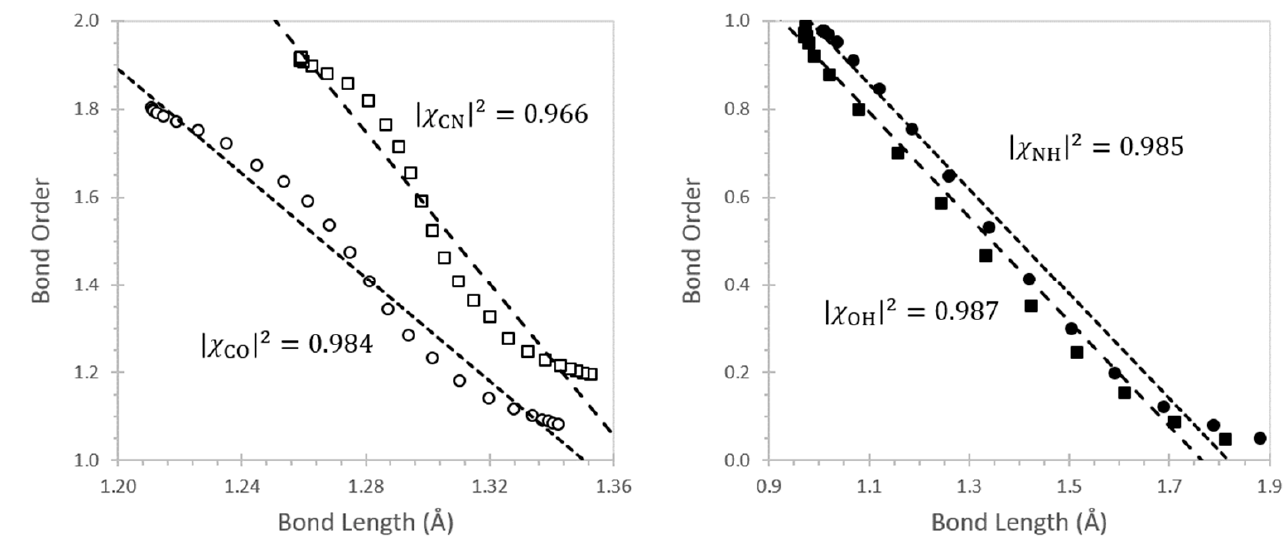
Figure 7. Bond order–bond length correlations for CO (circles), CN (squares), OH (filled circles), and NH (filled squares) bonds, showing the least-squares regression line and corresponding Pearson | χ | 2 correlation coefficient for each bond type. Variations in the NRT weights for the four resonance structures across the IRC, as well as concomitant changes in natural bond orders, are entirely consistent with the elec ‐ tron ‐ pushing, curly ‐ arrow representation that the bench chemist would use to depict the